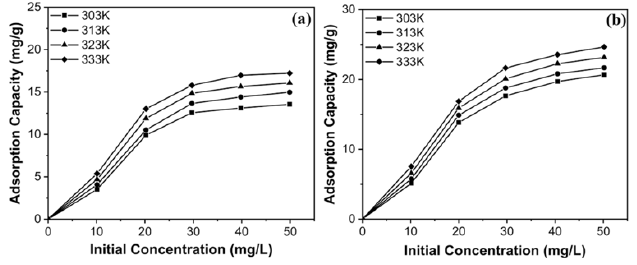
Fig. 5. Effect of initial concentration and temperature of Cr(VI) on RH and BC; adsorbent dose = 0.25 g; volume adsorbate = 0.25 L; shaking time = 120 min; pH = 3.4 ± 0.1; shaking speed = 180 rpm; Table 2. Adsorption parameter and constant of Cr(VI) on RH and BC